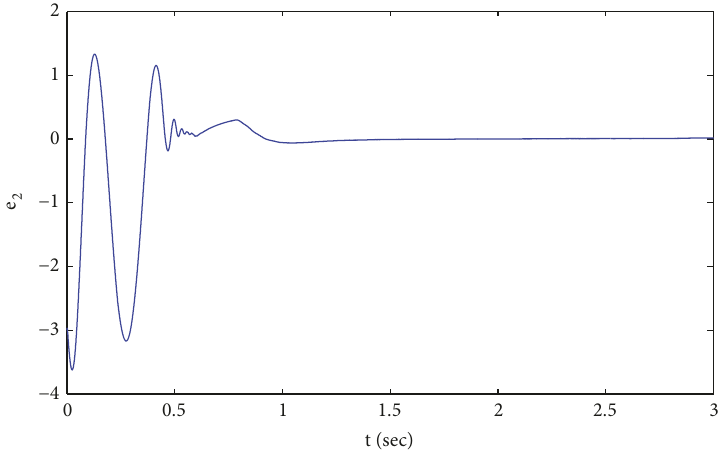
Figure 8: The time response of the error state 𝑒 2 .